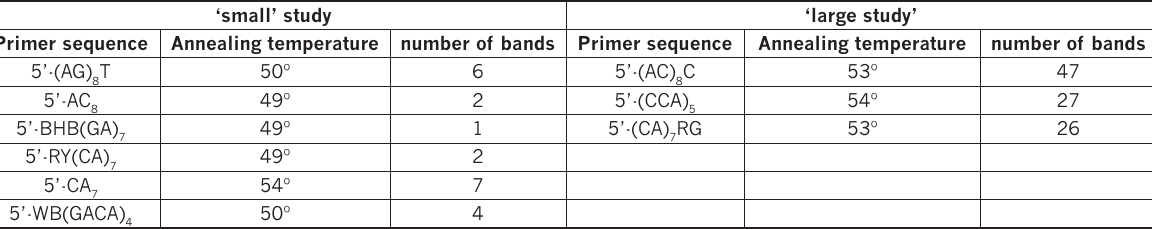
Figure 2. Map showing collecting localities for both ISSR studies. Inset shows position of Oklahoma (OK) relative to Arkansas (ARK1-3) populations. Shell of E. potosiensis from population OK is shown. Table 2. Sequences, annealing temperatures (ºC), and number of bands produced for ISSR primers used in each study. ‘small’ study ‘large